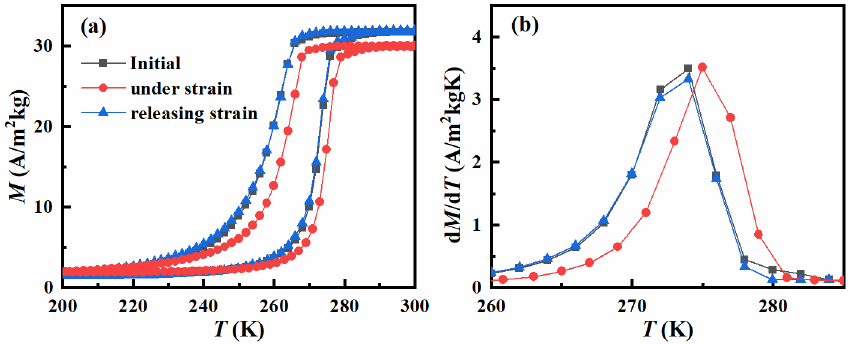
Figure 3. ( a ) Temperature-dependent magnetization curves in the cooling and heating process and ( b ) the corresponding d M /d T-T curves in the heating process under a magnetic field of 0.01 T for NCMS alloys in the initial state, compressive strain state, and after releasing the strain,